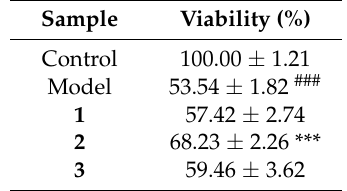
Table 2. Neuroprotective effects of compounds 1 – 3 at a concentration of 10 − 5 M (means ± SD, n =